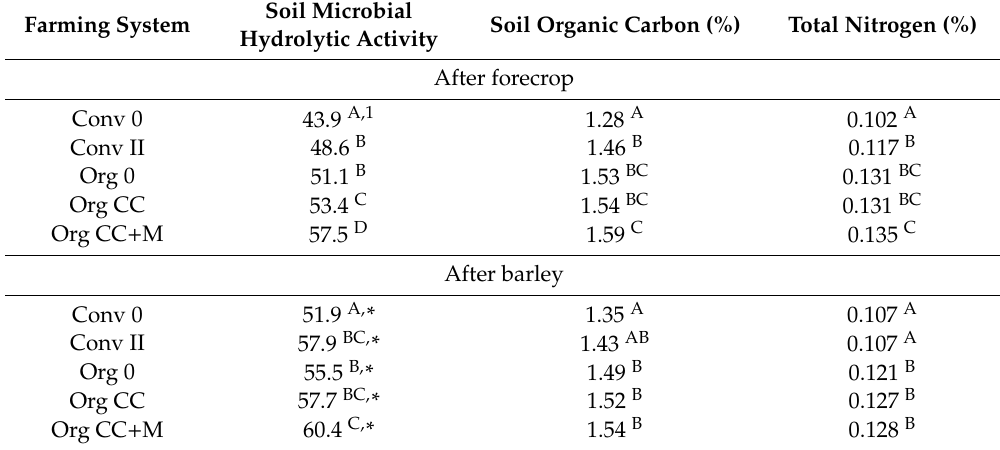
Table 2. Soil microbial hydrolytic activity ( µ g of fluorescein g − 1 soil dry weight h − 1 ), organic carbon (%) and total nitrogen content (%) after forecrop and after barley (us)